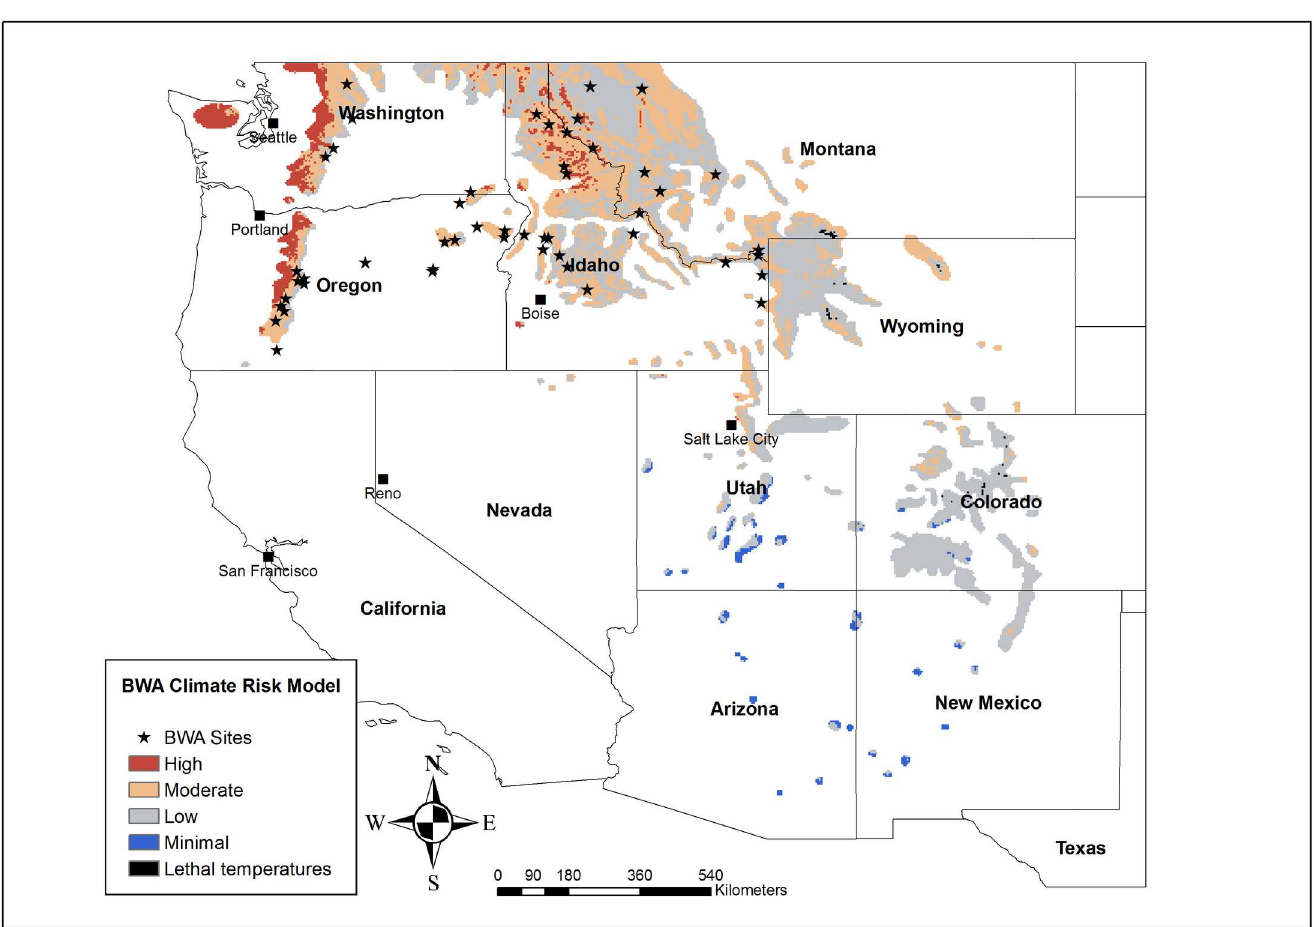
Fig 1. Locations of balsam woolly adelgid (BWA) damage severity sampling sites in California, Oregon, Washington, Idaho, and Montana. Color coding represents model projectionsof climatic risk for BWA damage for the entire range of subalpinefir in the western United States.